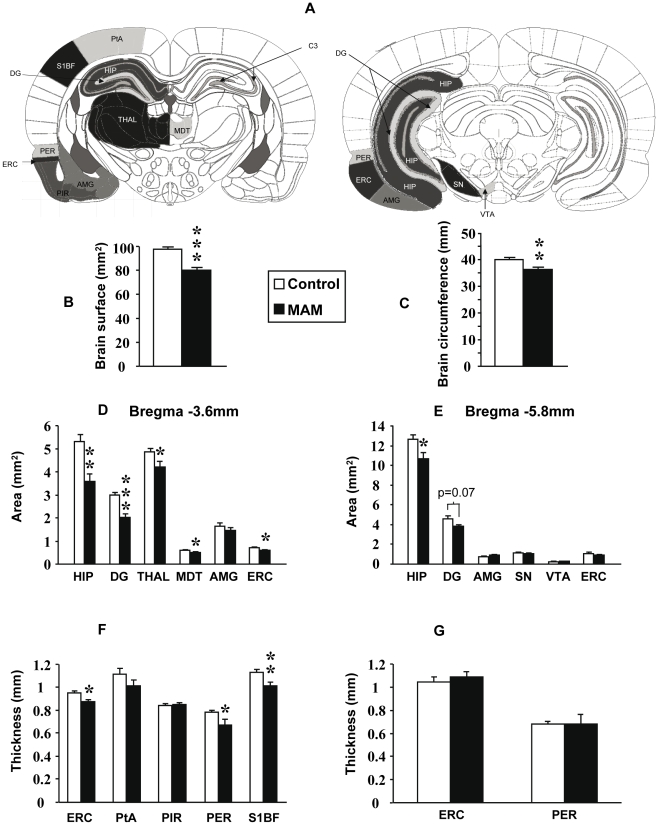
Morphometric effects of MAM E17 treatment on brain structures.(A) Brain diagrams reproduced with permission from The Rat Brain Atlas by Paxinos and Watson 6 edition illustrating how anatomical areas were delineated. Bregma −3.8mm on left and Bregma −5.8mm on right. Areas and thicknesses were measured as delineated in the pictures. (B–C) Graphs indicating differences in brain area (B) and circumference (C) between control (white bars) and MAM-exposed animals (black bars). (D–E) Graphs indicating area differences between MAM and control animals at Bregma −3.6 (D) and −5.8mm (E). (F–G) Graphs indicating differences in thickness between MAM and control animals at Bregma −3.6 (F) and −5.8mm (G). Results represent the mean ± S.E.M. of 9 animals per group from which slides done by duplicate were analyzed. Amygdala (AMG), associative parietal cortex (PtA), cornu ammonis (CA), dentate gyrus (DG), entorhinal cortex (ERC), hippocampus (HIP), mediodorsal thalamic nucleus (MDT), perirhinal cortex (PER), piriform cortex (PIR), somato-sensory cortex barrel field 1 (S1BF), substantia nigra (SN), thalamus (THAL), ventral tegmental area (VTA). *p<0.05 **p<0.01 and ***p<0.001.